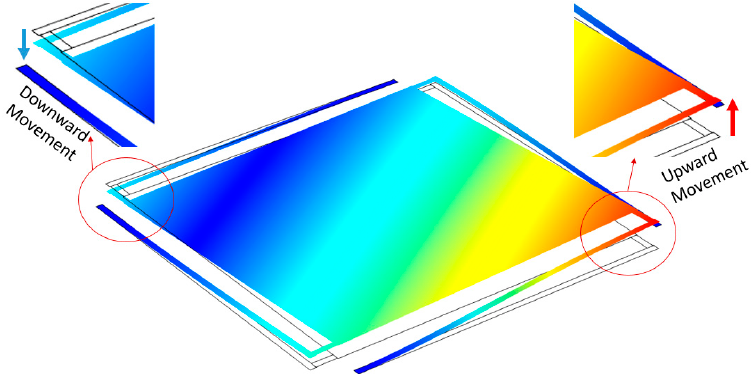
Figure 8. Schematic view of COMSOL simulation result showing the tilting of the micromirror surface where one end of the micromirror surface moves upward and the other end deflects downward with an unequal amplitude of deflection.